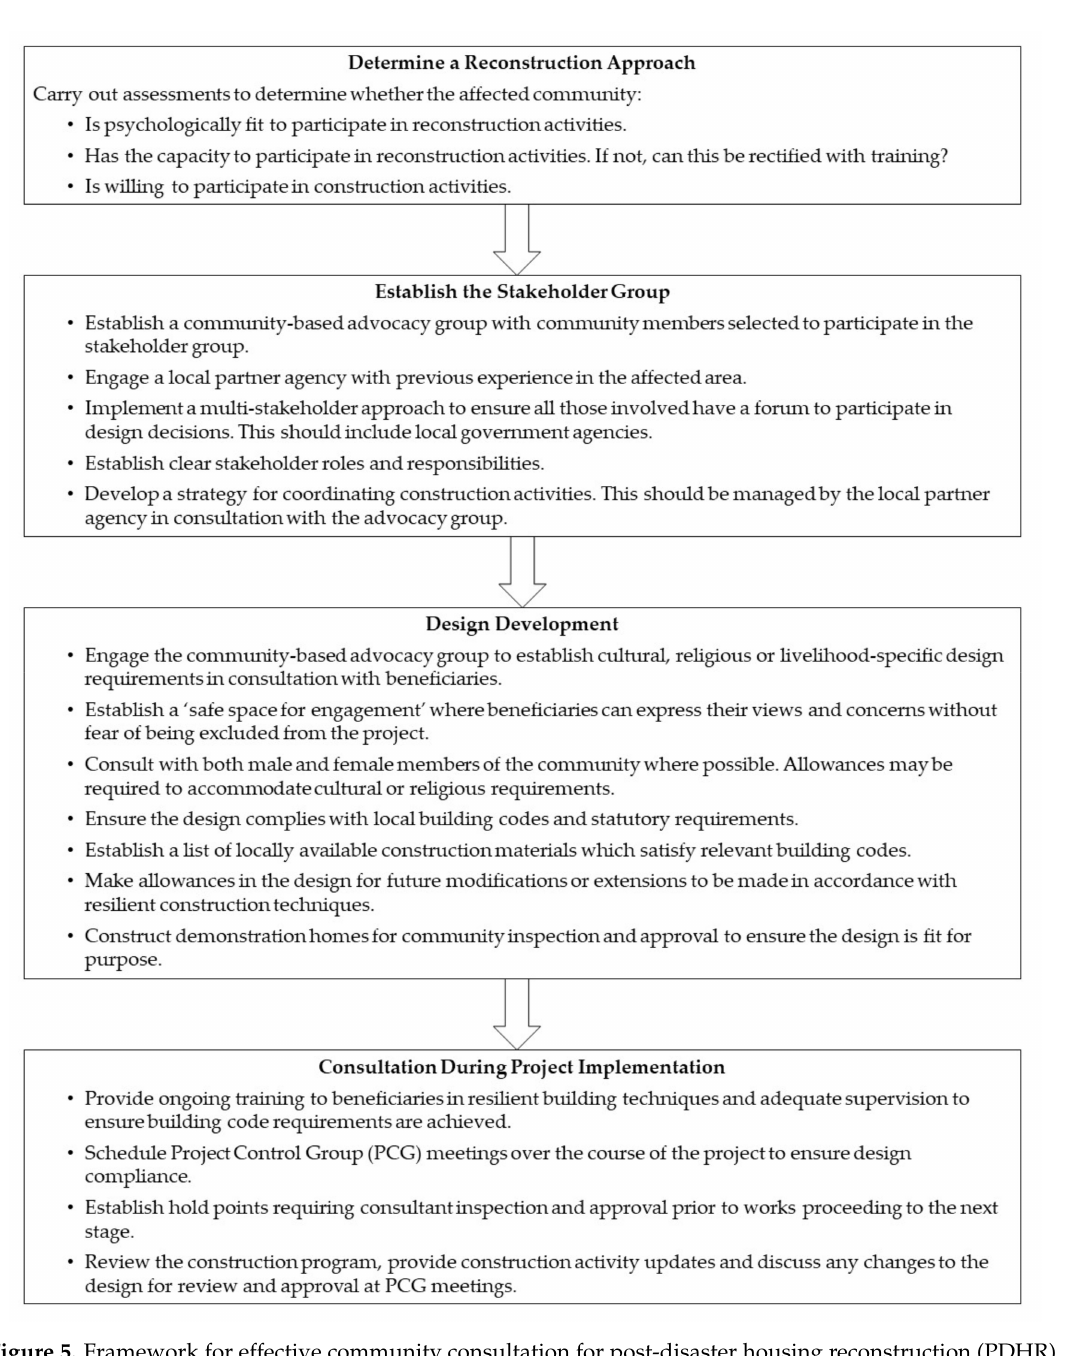
Figure 5. Framework for effective community consultation for post-disaster housing reconstruction